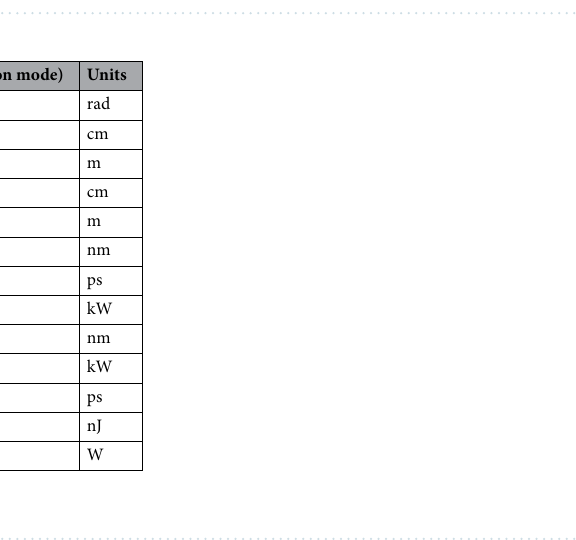
Figure 6. Radiation pulses and spectra at the exit of the radiator with high-flux mode (up) and high-resolution mode (down).